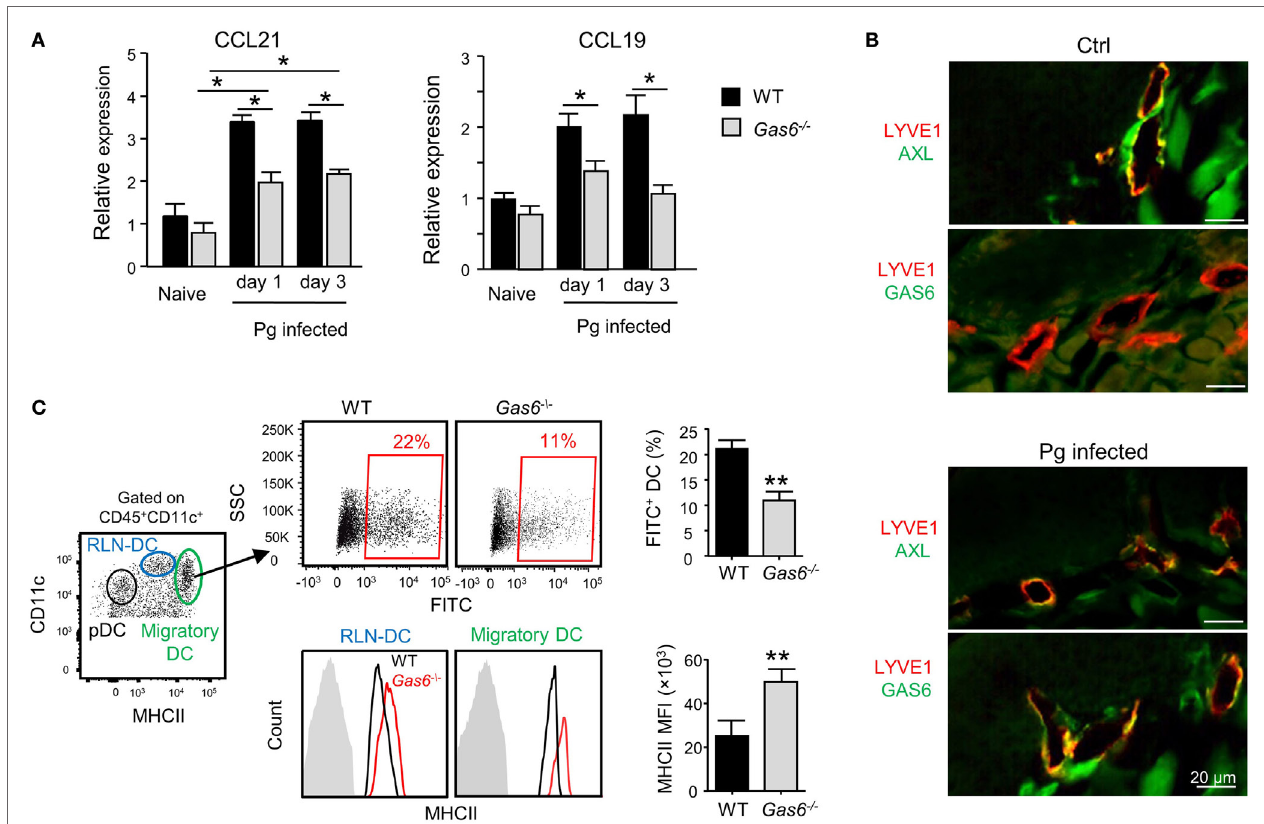
FigUre 6 | Growth arrest-specific 6 (GAS6) enhances migration of oral dendritic cells (DCs) to the draining lymph nodes (LNs). (a) Mice were infected once with Pg and the expression levels of CCL19 and CCL21 chemokines was analyzed in the gingiva using RT- q PCR 1 or 3 days later. Data represent the mean of five mice per group ± SEM. (B) Immunofluorescence staining of AXL or GAS6 (green) and LYVE1 (red), in gingival lamina propria cross sections of Pg -infected and naive WT and Gas6 − / − mice. Representative images of two independent experiments. (c) The oral mucosa of WT and Gas6 − / − mice were painted with FITC/DBP solution, 2 days later the draining cervical LNs were collected and processed for analysis by flow cytometry. Left plot —representative image demonstrating the segregation of CD45 + CD11c + cells into distinct DC subsets based on the expression of MHC class II and CD11c (RLN-DC—LN resident DCs; pDC—plasmacytoid DCs). Upper panel —representative FACS plots and bar graphs illustrating the percentages of FITC-positive cells among migratory DCs of Gas6 − / − and WT mice, representing the mean of five mice per group ± SEM. Lower panel —representative FCAS histograms showing MHCII expression levels on total migratory DCs and RLN-DCs. Gray histograms represent MHC staining on T cells which do not express MHCII. Bar graphs present the mean florescence intensity (MFI) of MHCII expression on the noted DC populations and represent the mean of five mice per group ±